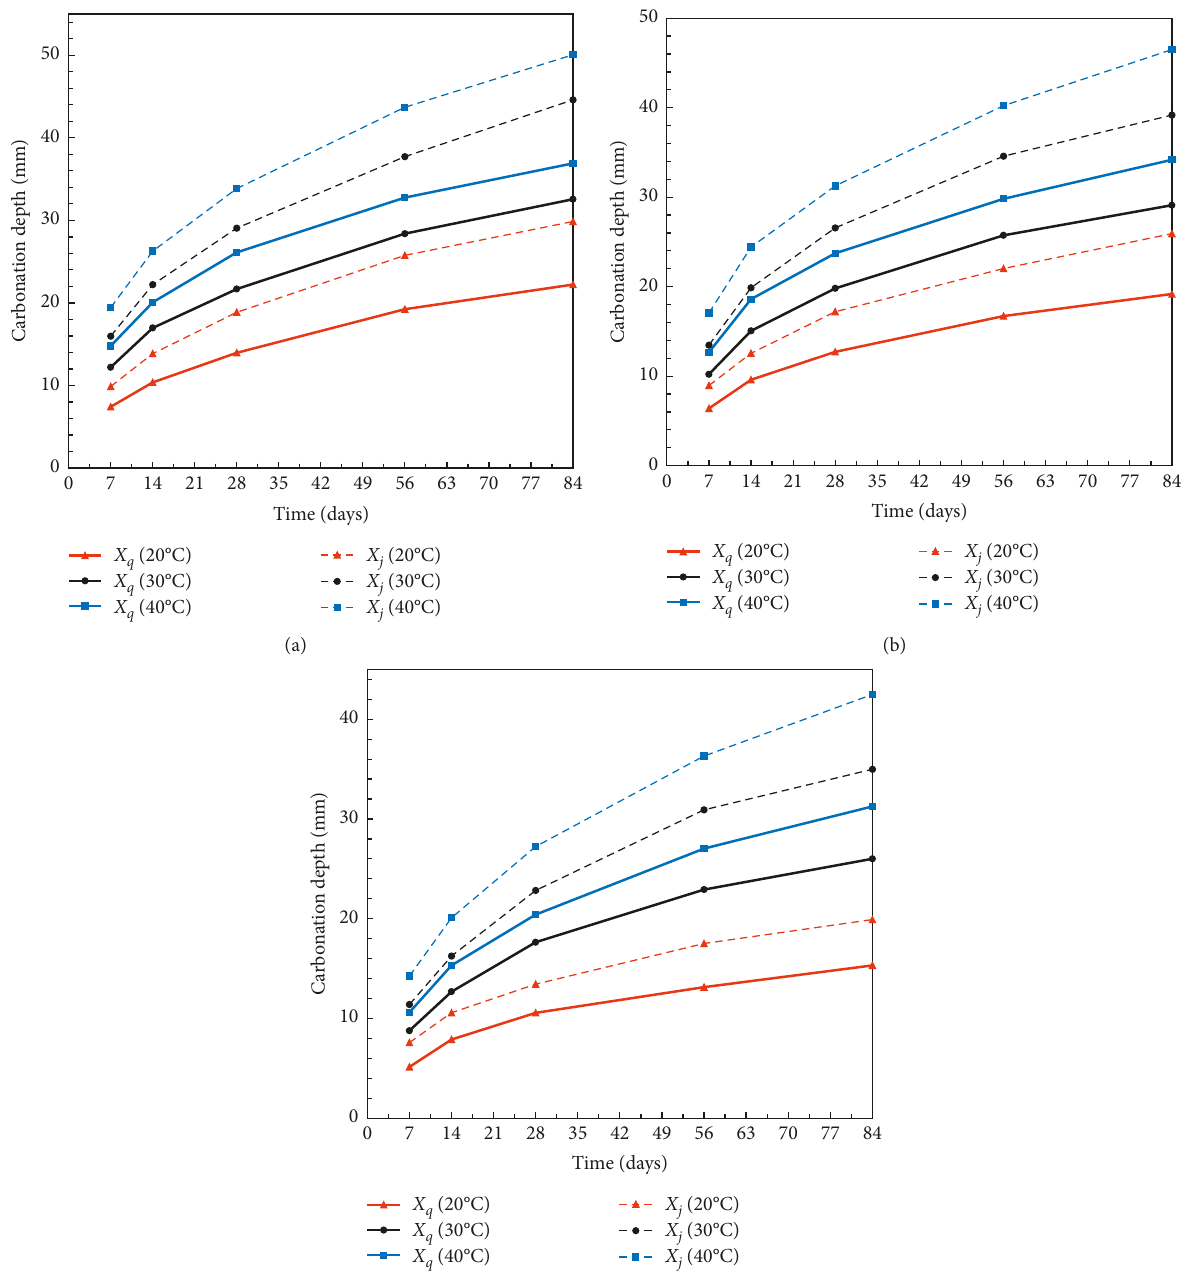
Figure 10: Carbonation depth curves: (a) C25 concrete ( w/c